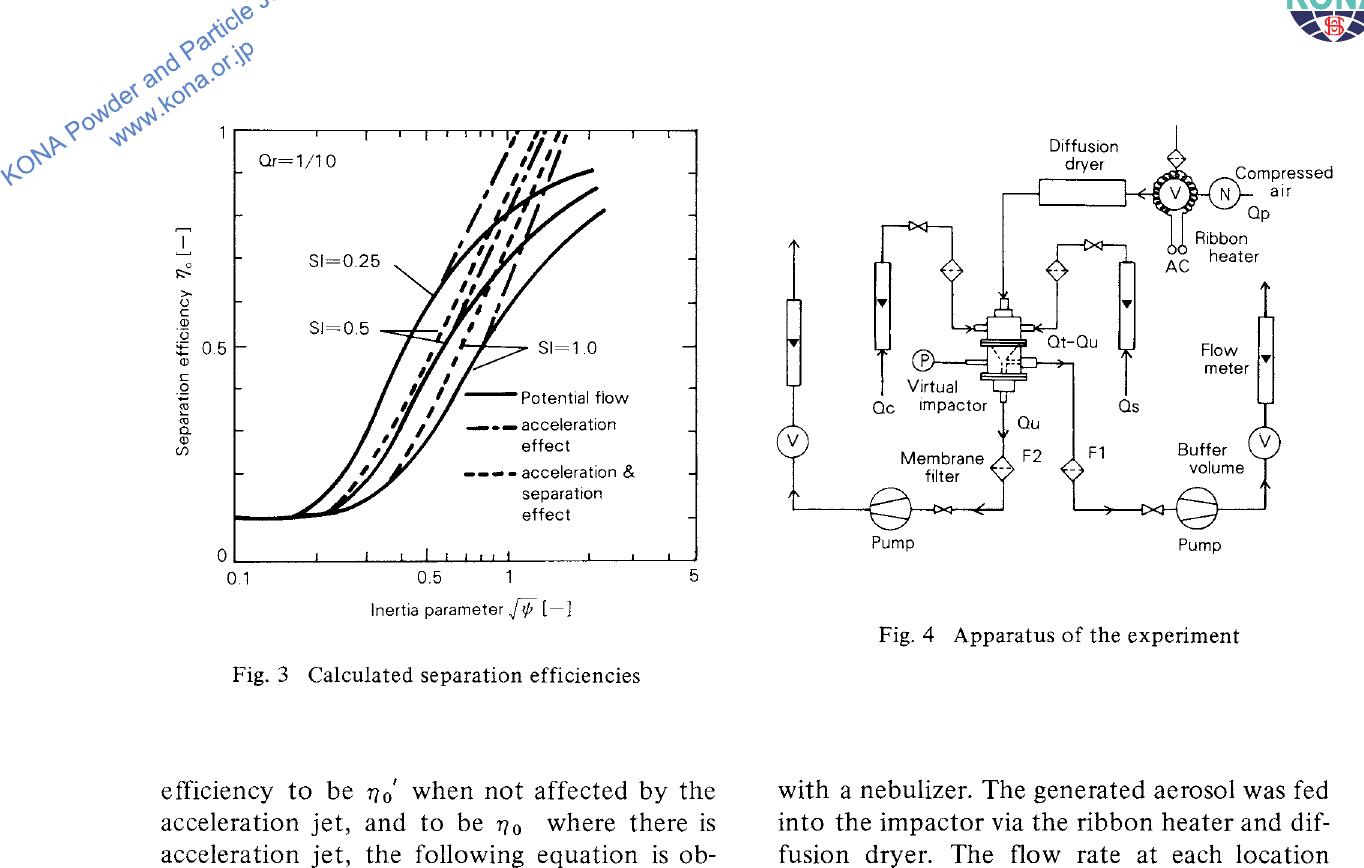
Fig. 3 Calculated separation efficiencies